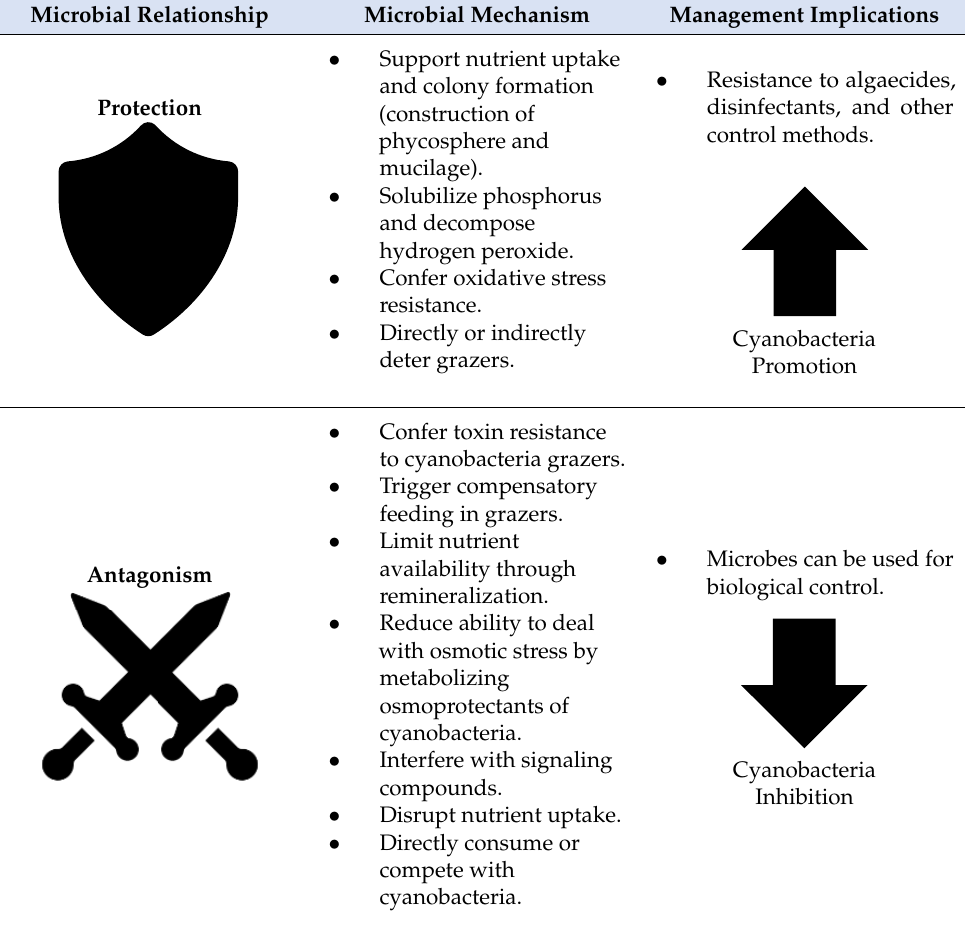
Table 1. How cyanobacterial interactions with other aquatic microbes pertain to HABs management. Microbial Relationship